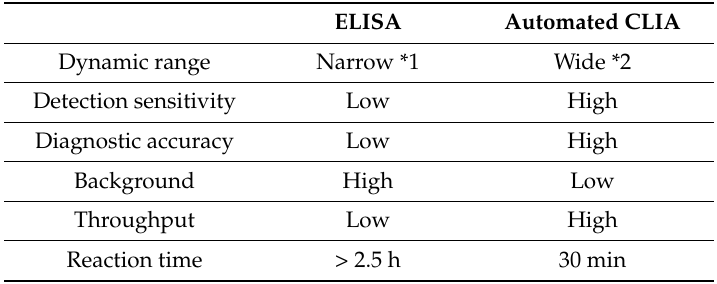
Figure 4. ( A ). Detection method for Chemiluminescent immunoassay (CLIA) ( B ), and its standard curve at different ranges using recombinant monomeric Ln- γ 2 protein. RLU; Relative Light Unit. Table 2. Comparison of measurement efficiency between LISA and CLIA.